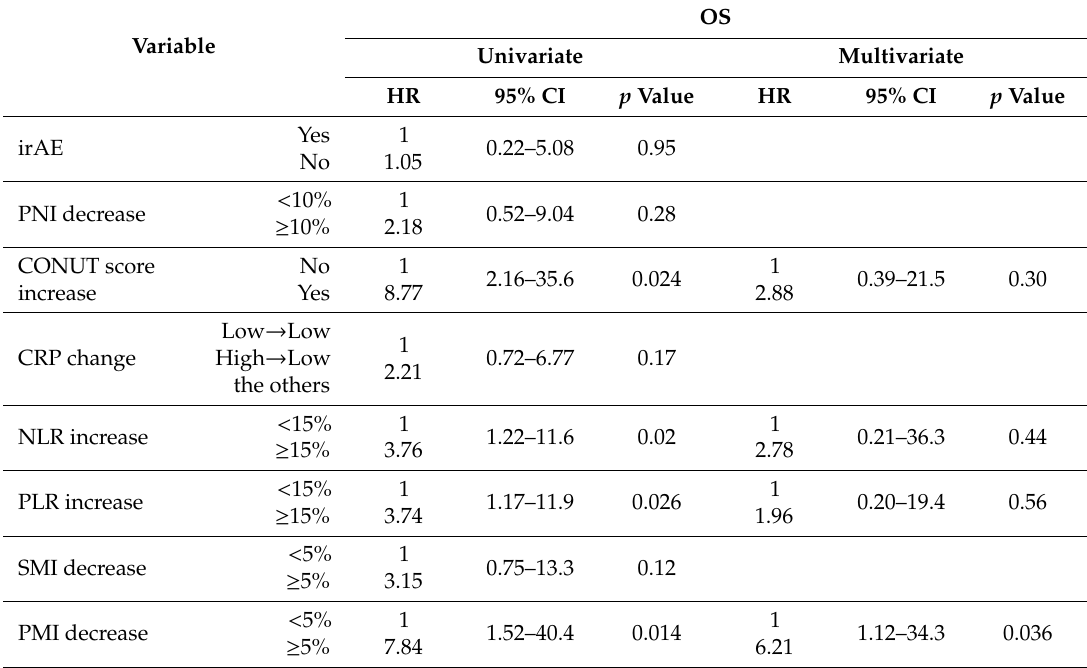
Table 5. Univariate and multivariate analysis for correlation between OS and changes of various markers 1M after the first